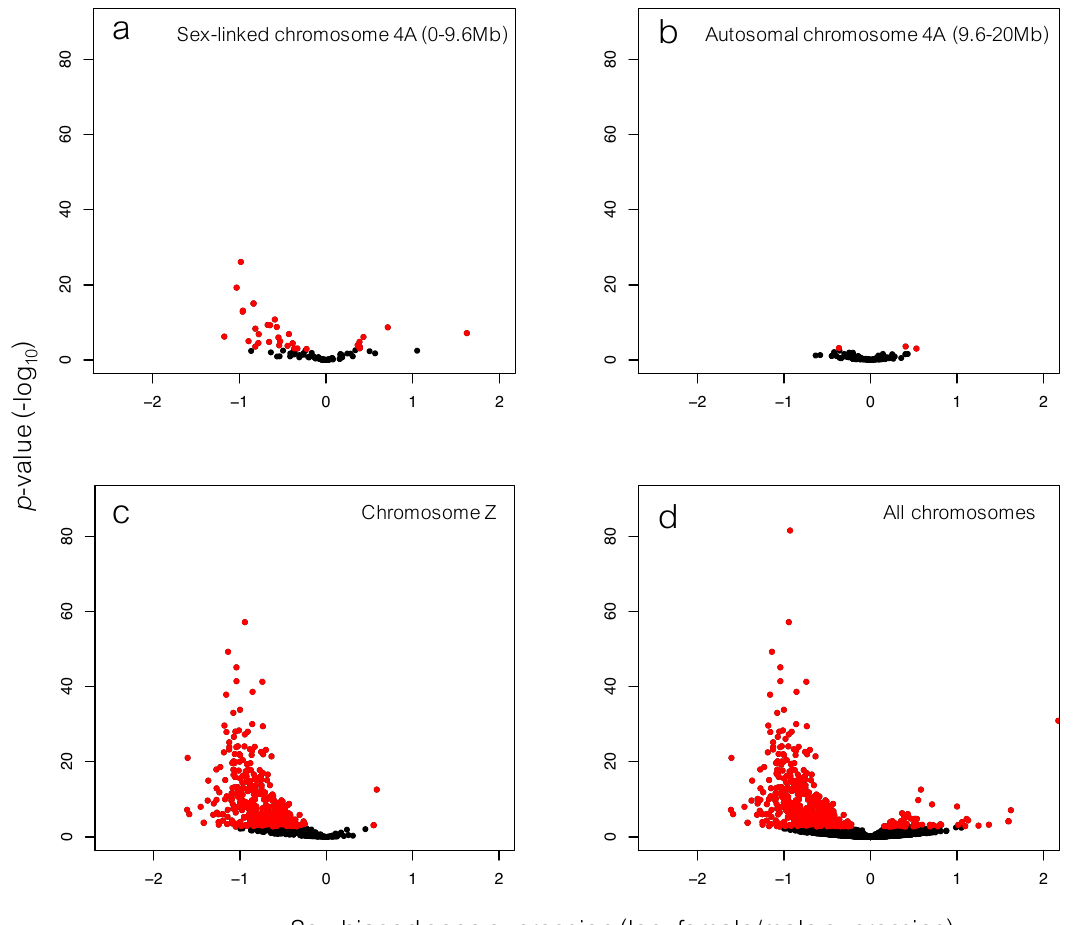
Figure 4. Volcano plot showing log 2 female/male gene expression (values > 0: female-biased genes; values < 0 male-biased genes) and significance levels. Red colour marks significant genes (p adj < 0.05). The genes located on chromosome 4A were divided into two parts: ( a ) those on the first 9.6 Mb of chromosome 4A, i.e., the neo-sex chromosome, and ( b ) those on the autosomal part of chromosome 4A. Also, shown are ( c ) genes located on chromosome Z, and ( d ) genes over the whole genome. Of the genes that were analysed for sequence divergence (neo-sex: n = 64; Z: n = 39), the mean expression in females was slightly lower than in males on the neo-sex chromosome (mean ± SE log2 female/male expression: − 0.02 ± 0.05, n = 64) and significantly lower in females for the